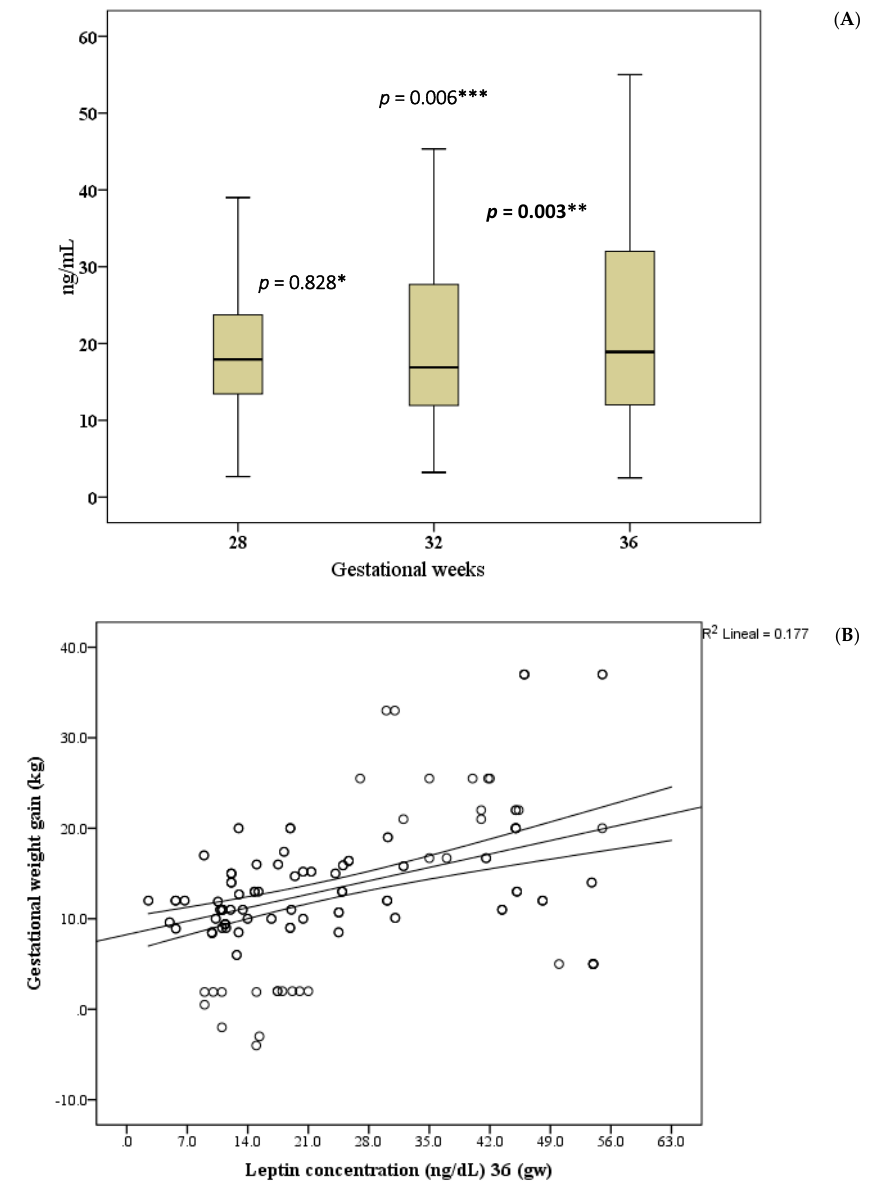
Figure 2. Leptin and gestational weight gain: ( A ) tendency of leptin (ng/mL) from 28 to 36 gestational weeks; (*): Gestation Week 28 and 32; (**): Gestation Week 32 and 36; and, (***): Gestation Week 28 and 36 and ( B ) correlation between gestational weight (kg) and leptin concentration (ng/mL) at Gestation Week